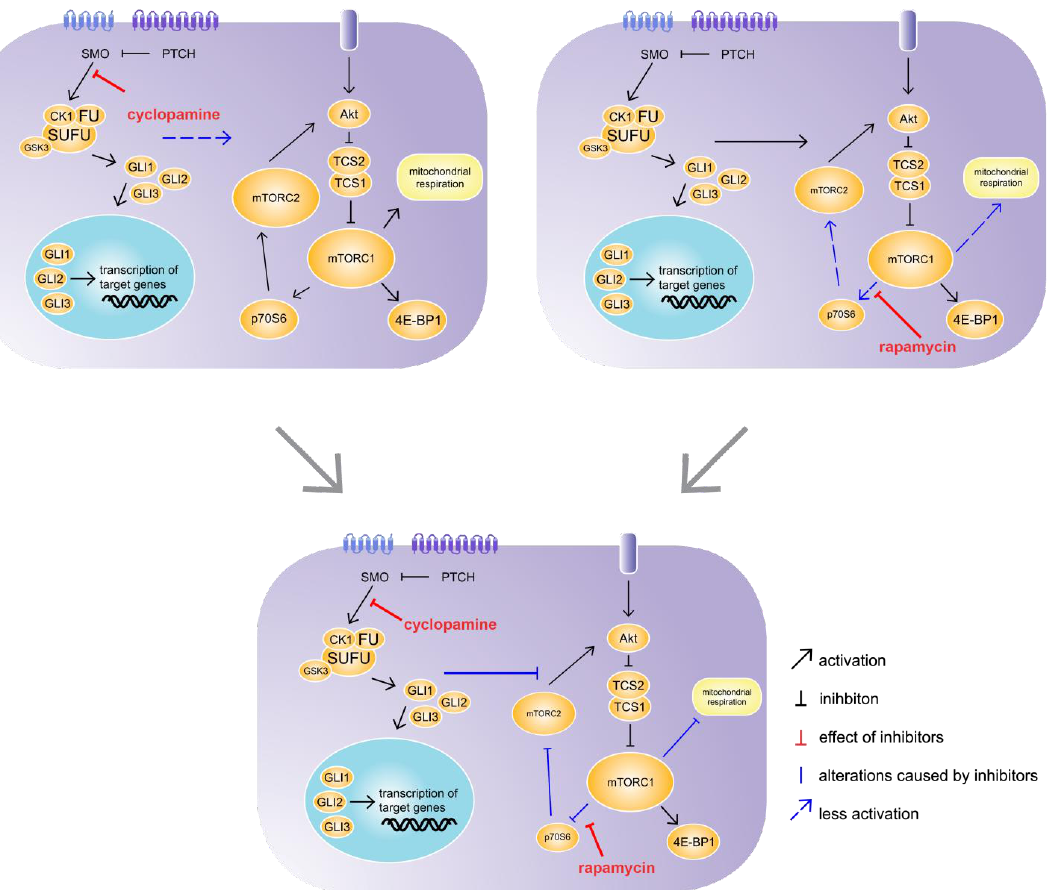
Figure 7. Synergistic effect of cyclopamine and rapamycin. C57BL/6N hepatocytes were treated with cyclopamine and/or rapamycin for 24 h. The treatment with cyclopamine had no effect on mechanistic target of rapamycin (mTOR) signalling, whereas the treatment with rapamycin had weak inhibitory effects on p70S6 downstream signalling and mitochondrial respiration. However, the simultaneous treatment with cyclopamine and rapamycin exhibited strong inhibitory effects on p70S6 downstream signalling as well as mitochondrial respiration, revealing an impact of Hh signalling on the mTOR pathway. SMO: Smoothened, PTCH: Patched, CK1: Casein kinase 1, FU: Fused, SUFU: Suppressor of Fused, GSK3: Glycogen synthase kinase 3, GLI1-3: glioma-associated oncogene family zinc finger 1-3, Akt: Protein kinase B, TCS: Tuberous sclerosis complex, mTORC1/2; mechanistic target of rapamycin complex 1/2, 4E-BP1: Eukaryotic translation initiation factor 4E-binding protein 1, p70S6: Ribosomal protein S6 kinase beta-1.